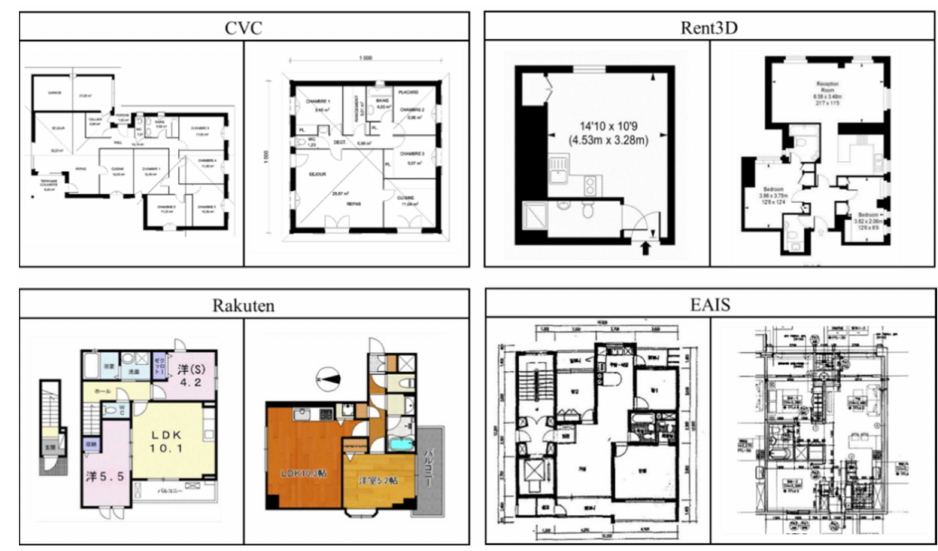
Figure 1. Examples of CVC, Rakuten, Rent3D, and EAIS